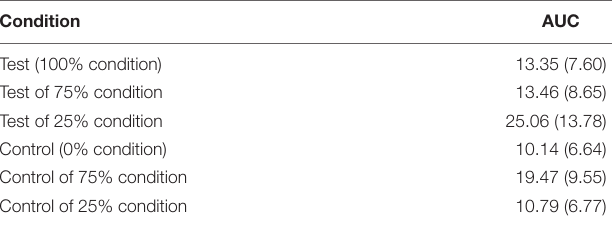
TABLE 3 | Mean area under the baseline curve (AUC) from 700 to 1,100 ms for all